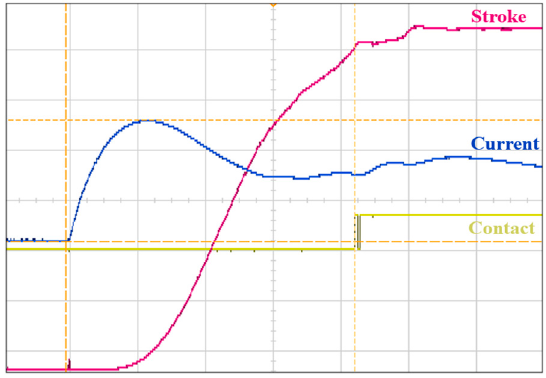
Figure 11. Characteristics of closing operation.